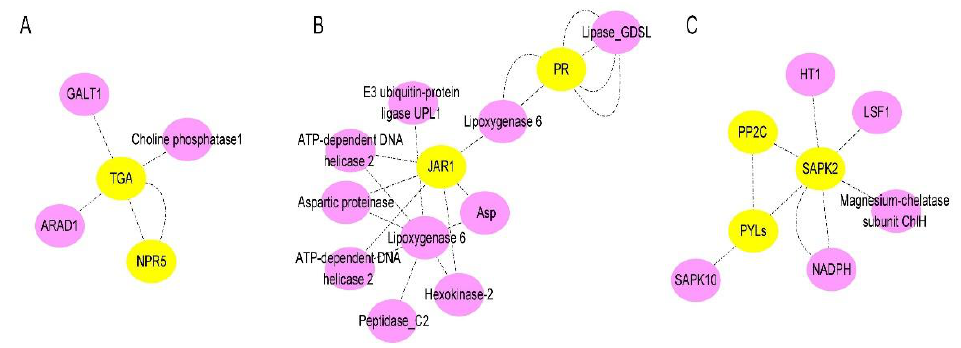
Figure 9. The schematic of SA, JA, and ABA signaling-related proteins network in watermelon: ( A ) Interaction network of SA signaling-related proteins in watermelon roots at 7 days after FON infection; ( B ) Interaction network of JA signaling-related proteins watermelon roots at 7 days after FON infection; ( C ) Interaction network of ABA signaling-related proteins watermelon roots at 7 days after FON infection. Each node in the diagram represents a protein, and each connecting line represents the interaction between connected proteins.